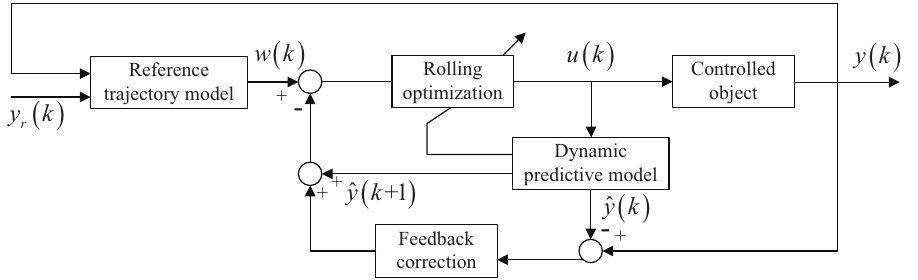
Figure 12. The structure of dynamic matrix control (DMC).